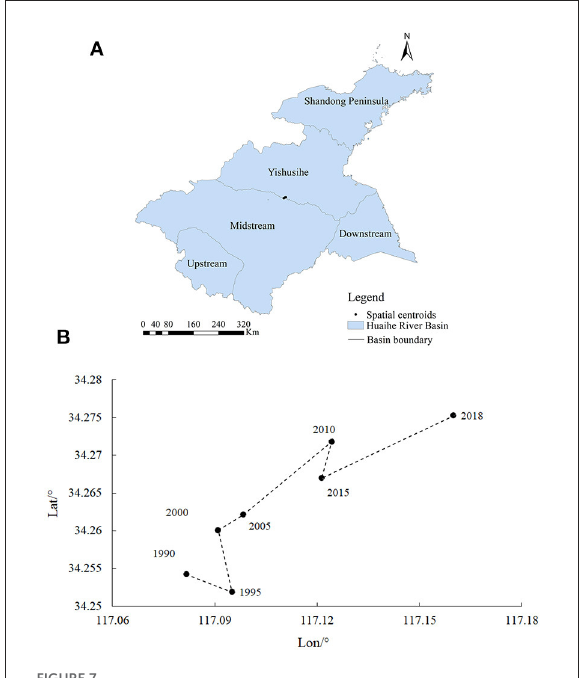
FIGURE7 (A, B) Spatial distributions of cold and hot spots of the human disturbances in the study